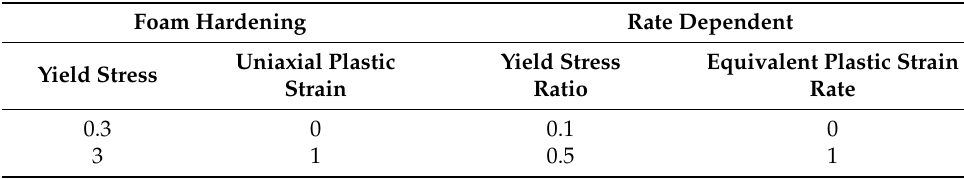
Table 1. Properties of the crushable foam material used.